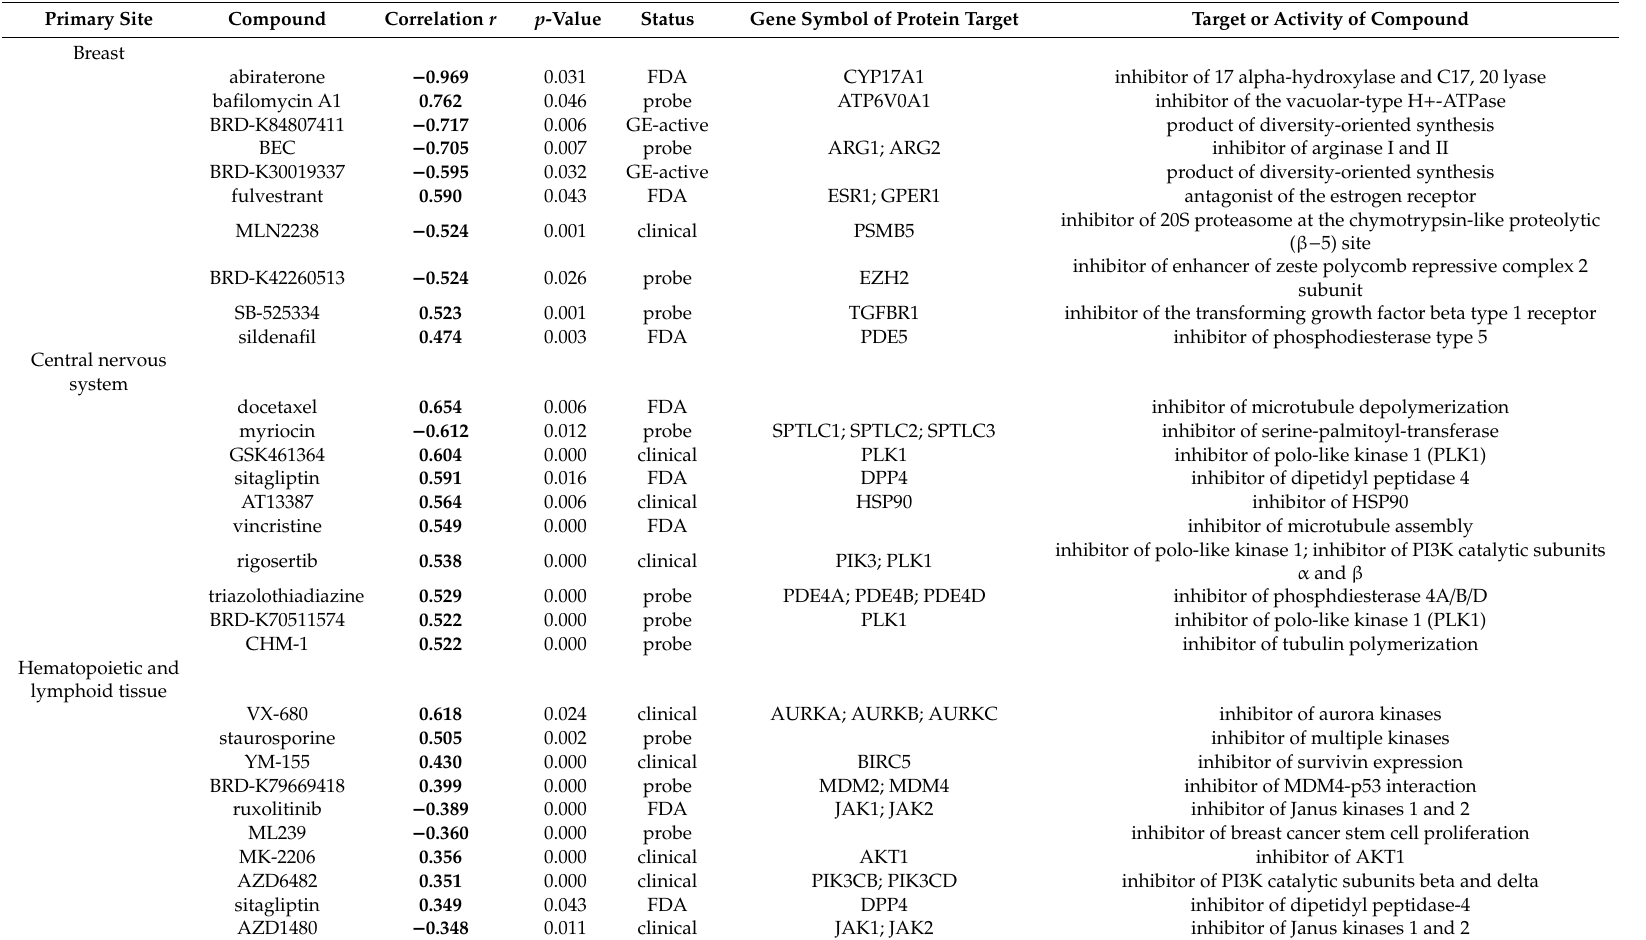
Table 1. The correlation between STAT3 expression and drug response (Top